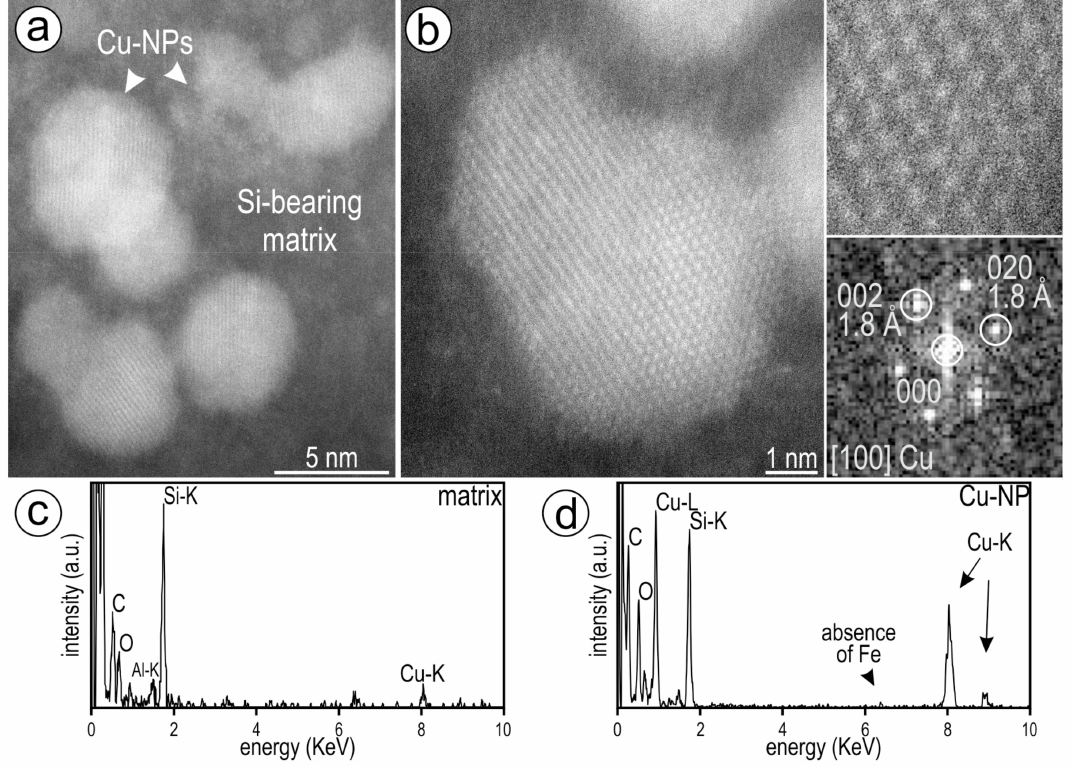
Figure 9. ( a , b ) Atomic-scale resolution images of native copper NPs. ( a ) Agglomeration of Cu NPs placed adjacent to the empty void in Figure 8a. ( b ) Distribution of Cu atoms in one of the NPs in ( a ) showing a square arrangement (cropped area upper right side) corresponding to zone axis [100] in native copper as indexed from FFT in the image bottom right. ( c , d ) STEM EDX spectra of substrate and Cu NPs. Note absence of Fe in both spectra. The carbon peaks on both spectra are partially due to the contamination in the chamber during prior high-resolution